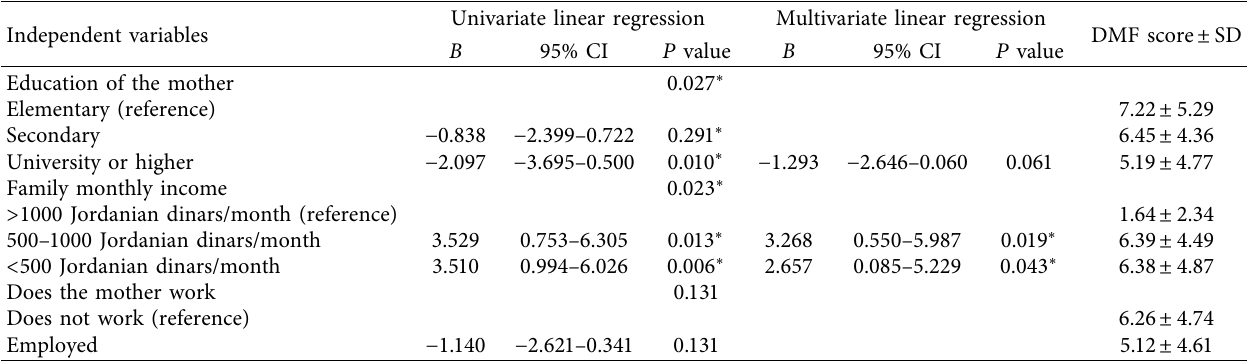
Table 5: Linear regression analysis of possible predictors of the DMF scores of the